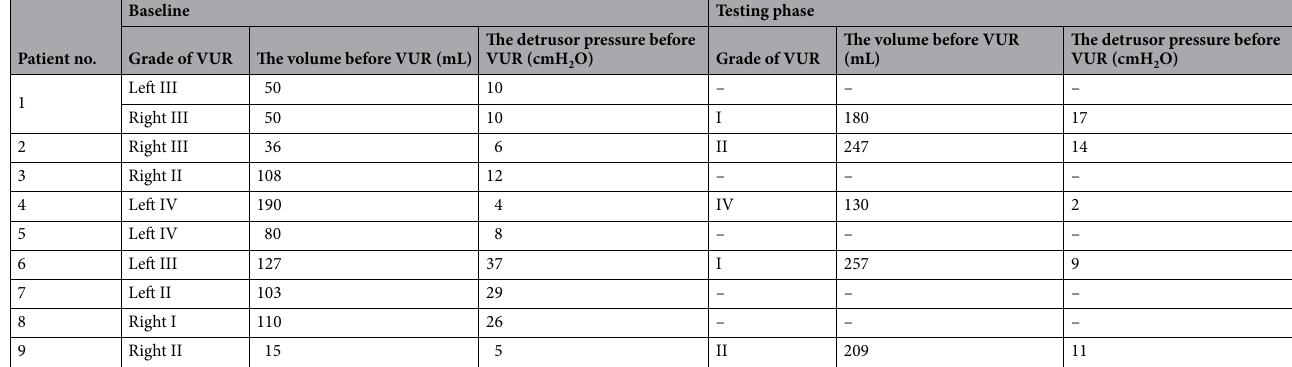
Table 4. Improvement of VUR during the baseline and testing phase.